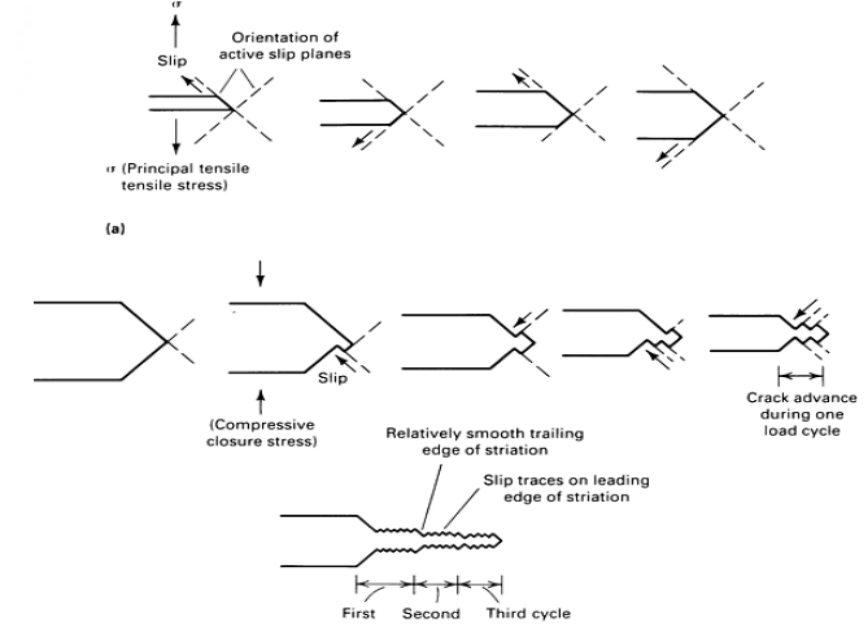
Figure 10: Failure mechanism in fatigue testing [37].